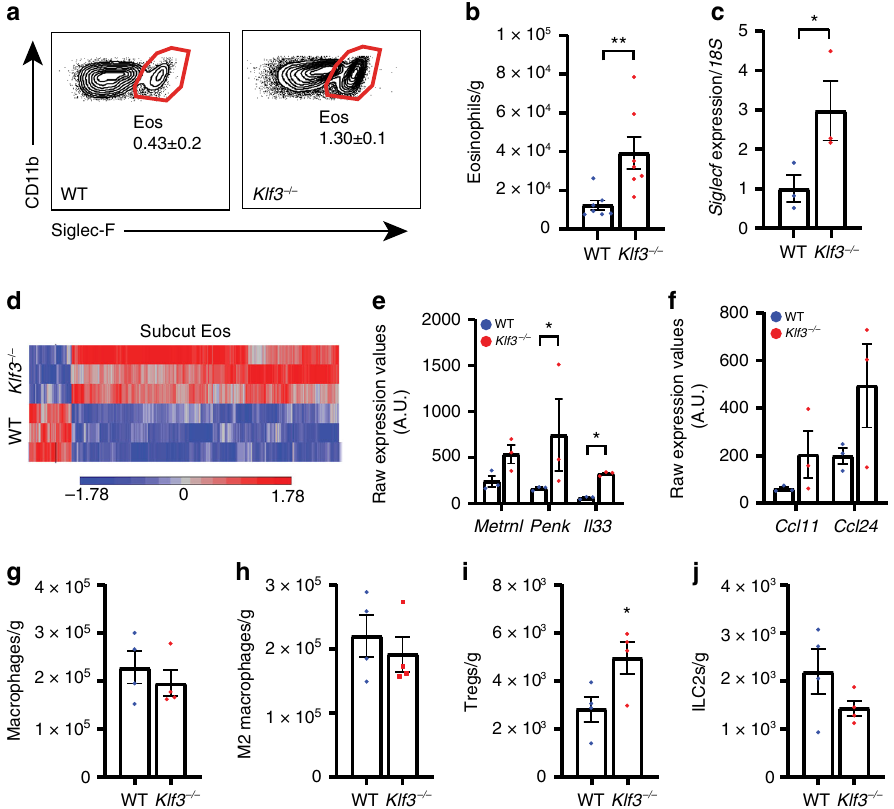
Fig. 4 AT-resident eosinophils are altered in the absence of KLF3. a Flow cytometry was used to analyse the abundance of Siglec-F + eosinophils in the SVF of WT and Klf3 − / − subcut AT. Representative plots of Siglec-F + eosinophils as a percentage of live cells are shown accompanied by the means ± SEM of n = 3 mice per genotype. b The total number of eosinophils per gram of subcut AT was calculated by sorting the entire SVF from WT and Klf3 − / − mice ( n = 7 mice). c mRNA levels of the murine eosinophil surface marker Siglecf were assessed by qPCR ( n = 3 mice). Relative expression was normalised to levels of 18S rRNA. d Eosinophils isolated from the subcut SVF of WT and Klf3 − / − mice by FACS were subjected to RNA extraction for microarray analysis, available at GEO (Accession No. GSE117445) ( n = 3 mice). A heatmap was constructed showing signi fi cantly deregulated genes ( P < 0.05, two-way ANOVA using false discovery rate, FDR, to correct for multiple comparisons). e Three genes with reported roles in beige fat activation and AT homeostasis were identi fi ed as signi fi cantly upregulated in Klf3 − / − AT eosinophils and their raw expression values were calculated by robust multi-array average (RMA) normalisation, with error bars representative of the means ± SEM of n = 3 mice per genotype. f Raw expression values for eotaxins Ccl11 and Ccl24 were also calculated in WT and Klf3 − / − subcut AT eosinophils ( n = 3 mice). Abundance of g macrophages (live CD45 + CD11b + CD64 + cells ) and h M2 macrophages (live CD45 + CD11b + CD64 + CD206 + CD11c − cells) in the SVF of WT and Klf3 − / − subcut AT was determined by fl ow cytometry and normalised to tissue weight ( n = 4 mice). Abundance of i Tregs (live CD45 + CD19 - CD3 + CD4 + CD25 + cells) and j ILC2s (CD45 + Lin − CD127 + CD25 + cells) were also determined by fl ow cytometry and normalized to tissue weight ( n = 4 mice). For b , c and e – j error bars represent means ± SEM and one- sided non-parametric Mann – Whitney U tests were performed where * P < 0.05, ** P < 0.01. Source data are provided as a Source data fi le. Eos, eosinophils; Tregs, regulatory T cells; ILC2s, group 2 innate lymphoid cells; A.U., arbitrary units. See also Supplementary Figs. 6 –